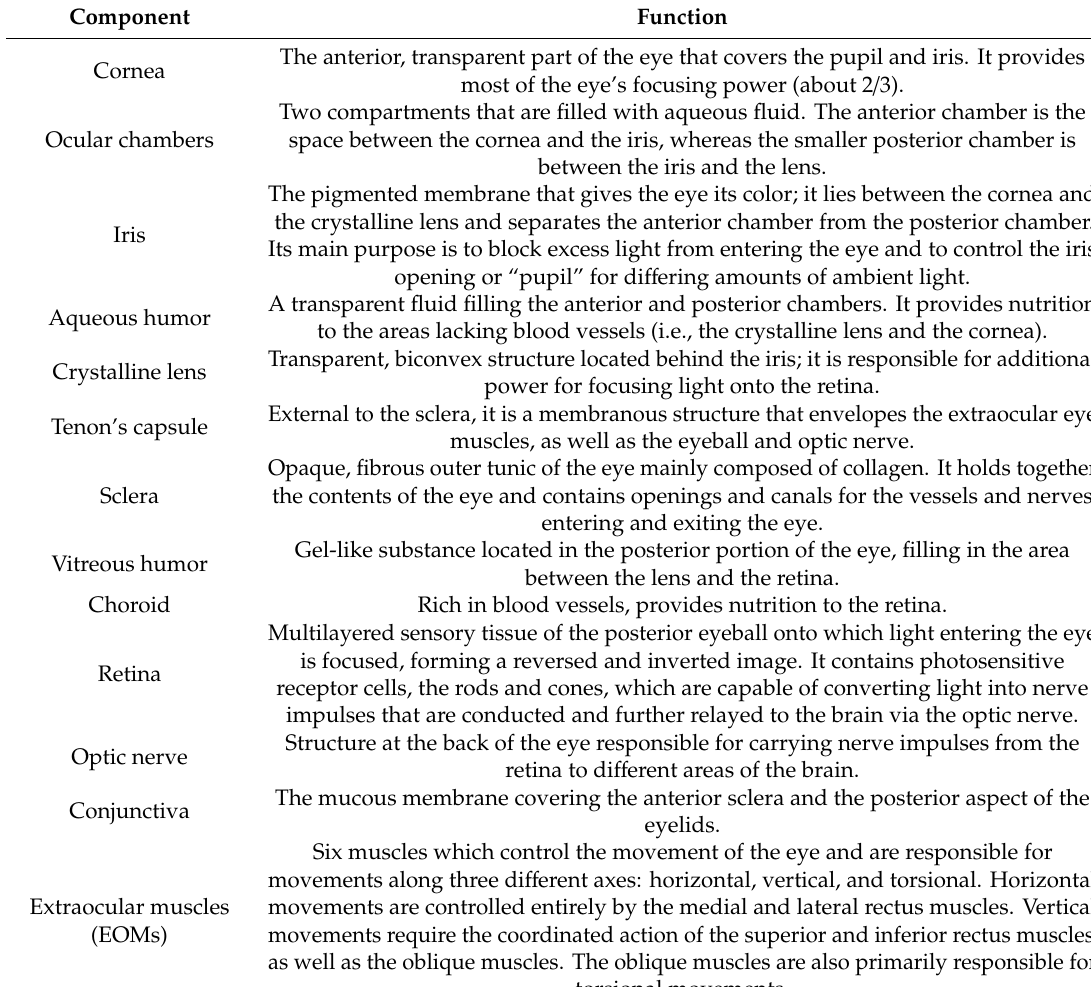
Table 1. Components of the eye and their